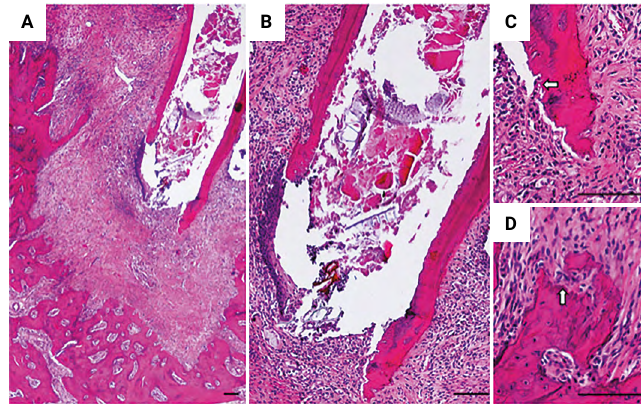
Figure 4. Microphotographs showing HE stained histological sections of the experimental distal root of the left mandibular first molar (E2) that received regenerative endodontic therapy (A). Blood cells and MTA particles can be seen inside the root canal (B). Although there is no evidence of HERS, some cells can be seen lining the root canal walls (arrow in C). Active osteoblasts and a thin layer of osteoid can be seen on the alveolar bone surface (arrow in D). Bars represent